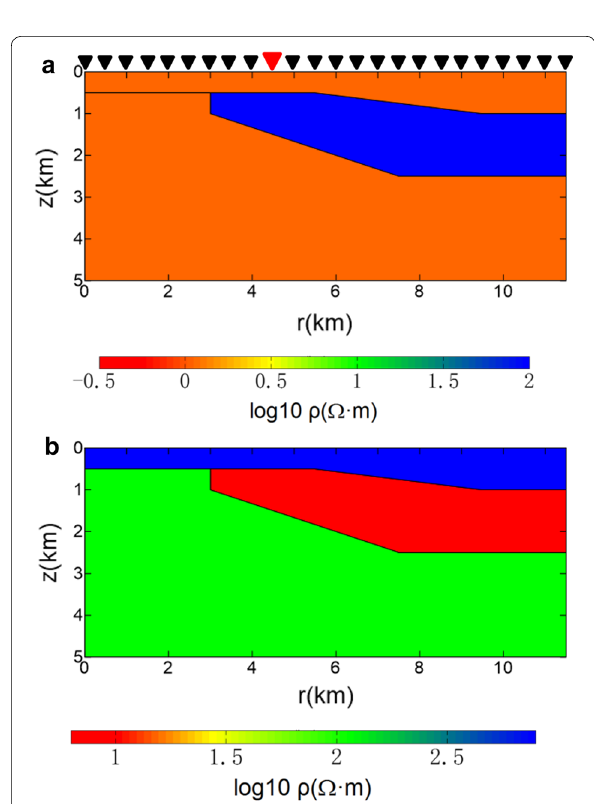
Fig. 7 Synthetic 2D models. a Resistive wedge model, b conductive wedge model. Black triangle indicates the site location for which the synthetic TE and TM responses are shown in Fig.